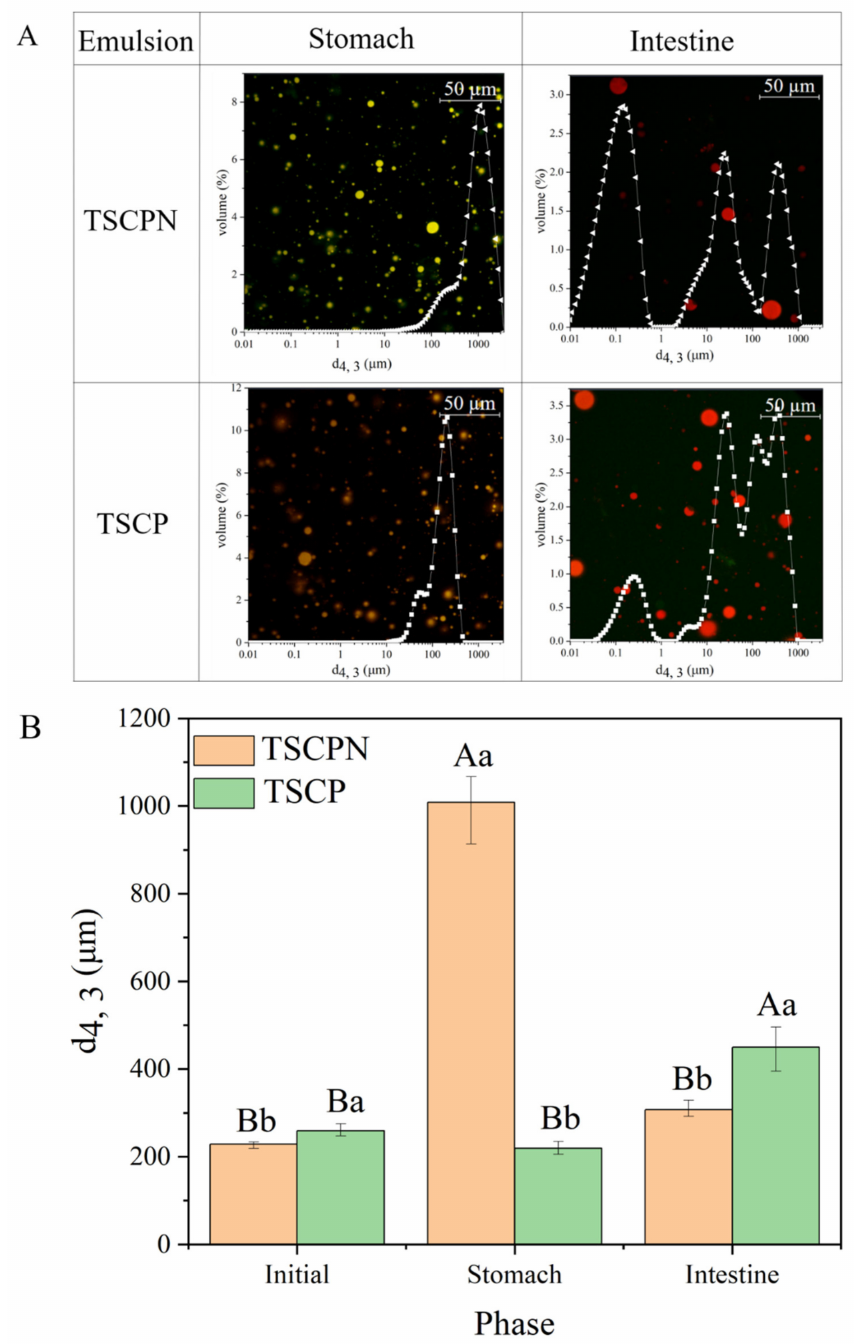
Figure 8. CLSM images, particle size distribution ( A ) and particle size (d4, 3) ( B ) of TSCPN-stabilized Pickering emulsion and TSCP-stabilized emulsion at different digestion periods. Different lowercase letters indicate significant differences between TSCPN-stabilized Pickering emulsions and TSCP- stabilized emulsions ( p < 0.05), and different uppercase letters indicate significant differences at different digestion stages ( p <